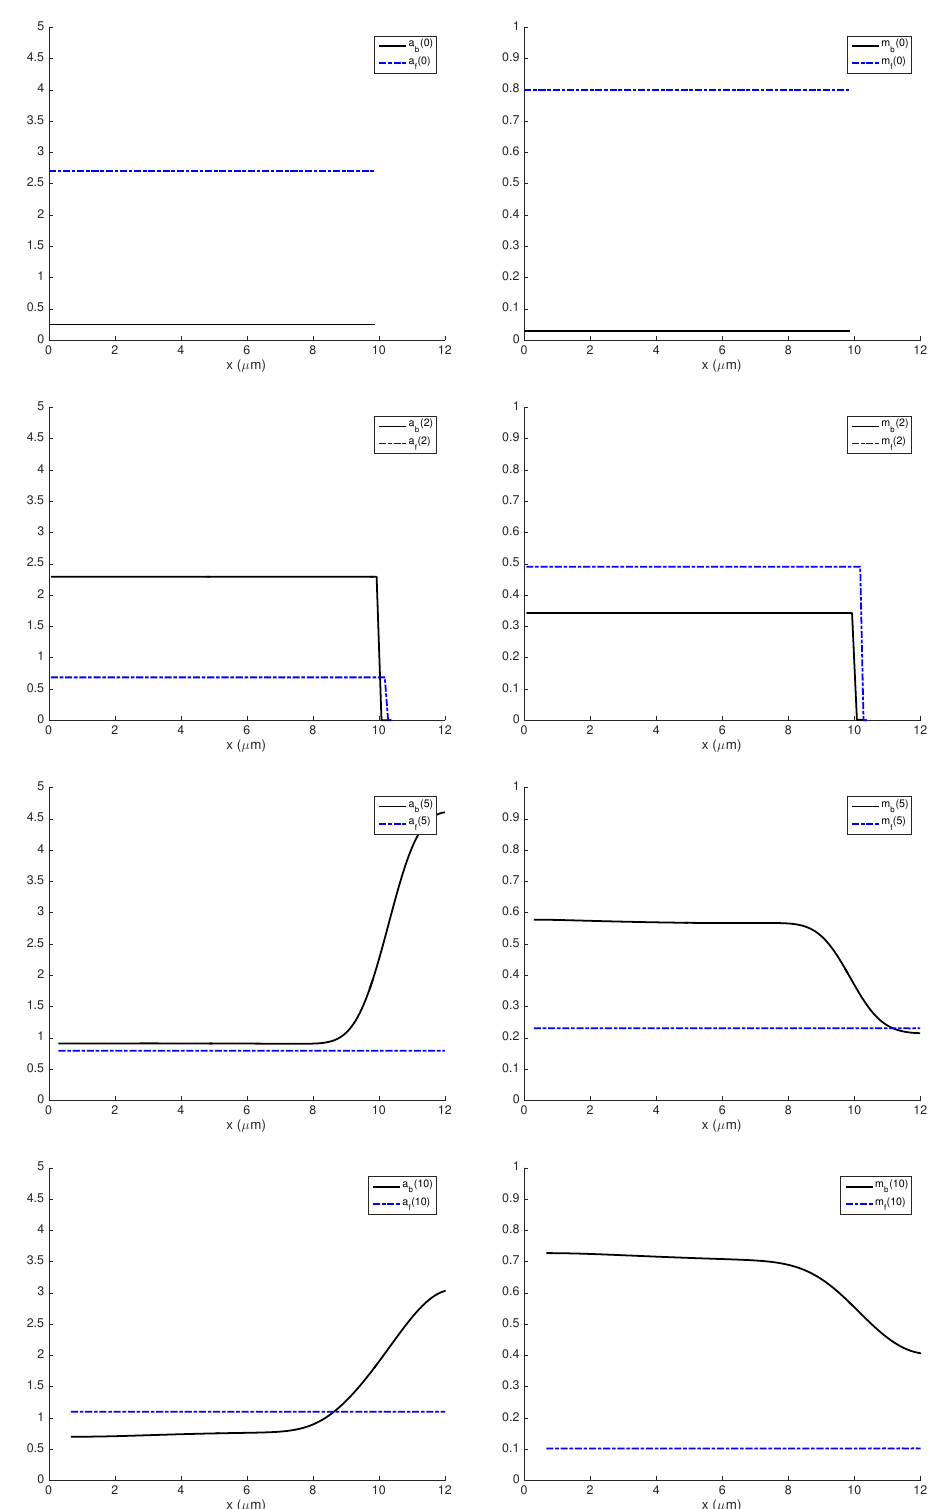
Figure 5. Actin and myosin concentrations during 10 s of the simulation: ( Left ) bound (solid) and free (dashed) actin concentrations at the initial time and at time instants t = 0,2,5, 10 s; ( Right ) bound (solid) and free (dashed) myosin concentrations at the initial time and at time instants t = 0,2,5,10